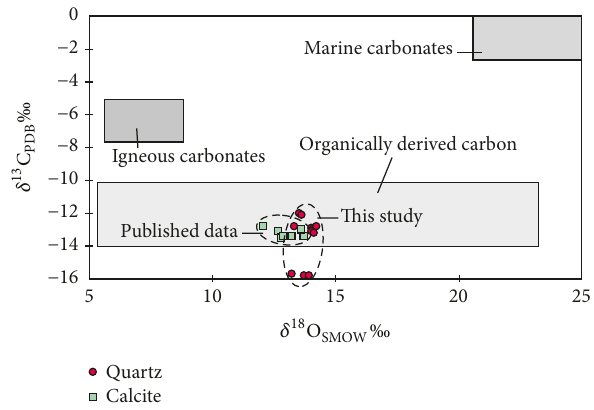
Figure 10: 𝛿 13 C versus 𝛿 18 O diagram showing the distribution of carbon and oxygen isotope data for the Bairendaba Ag-Zn-Pb deposit relative to fields for marine and magmatic carbonates [52] and organically derived carbon [53]. The data for calcite are from Ouyang